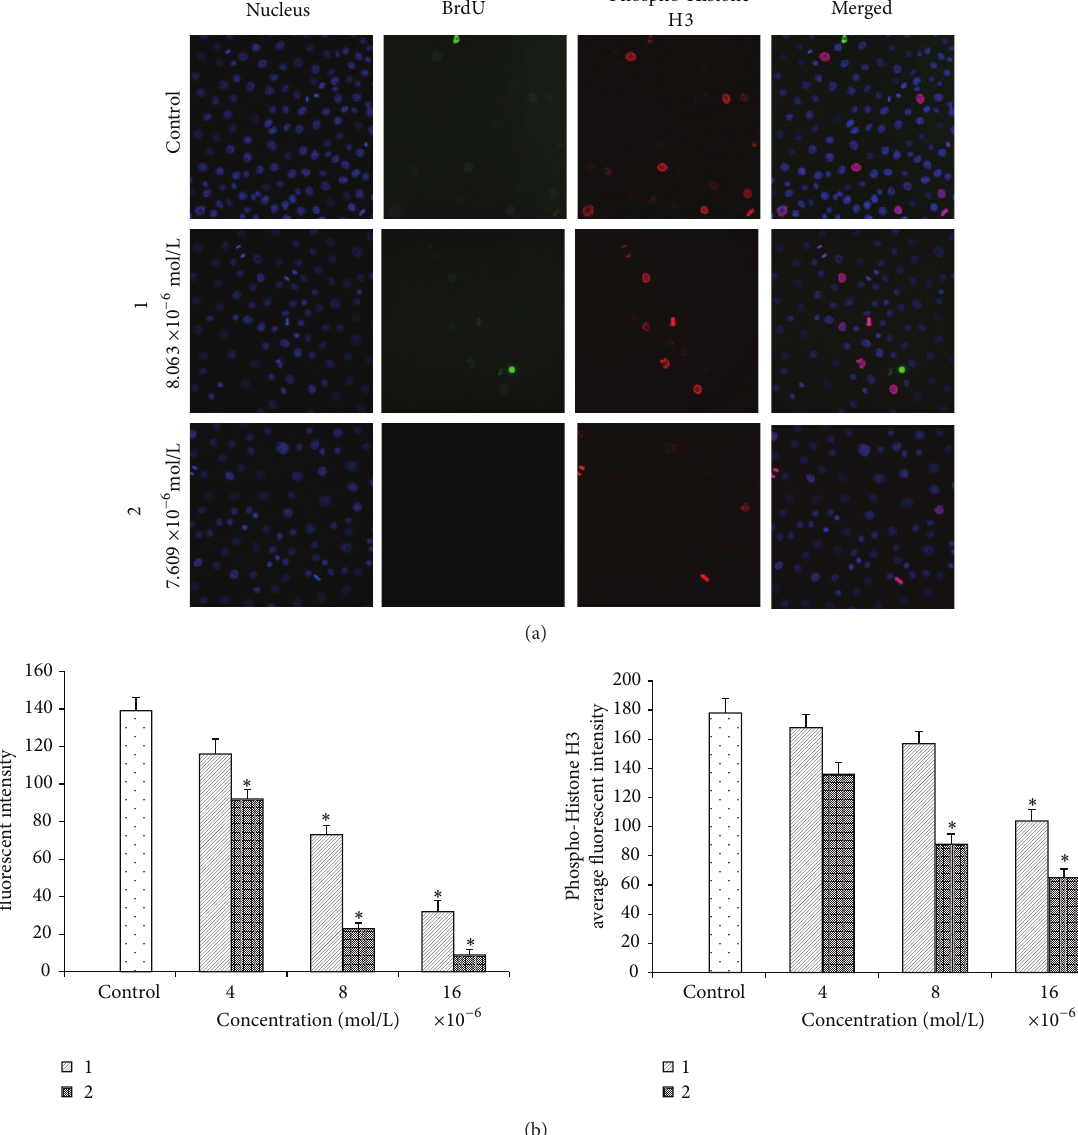
Figure 12: Cell cycle analysis. (a) Effect of (1) and (2) on cell cycle arrest. After incubation with DMSO or different concentrations of (1) and (2) for 24 h, MCF-7 cells were stained with BrdU and phosphohistone H3 and subjected to the Cellomics ArrayScan HCS reader for cell cycle analysis. (b) Representative bar charts indicating that treatment of both compounds markedly decreased BrdU and phosphohistone H3 fluorescence intensities in treated MCF-7 cells. Data were expressed as the mean ± SD of fluorescence intensity readings for three independent